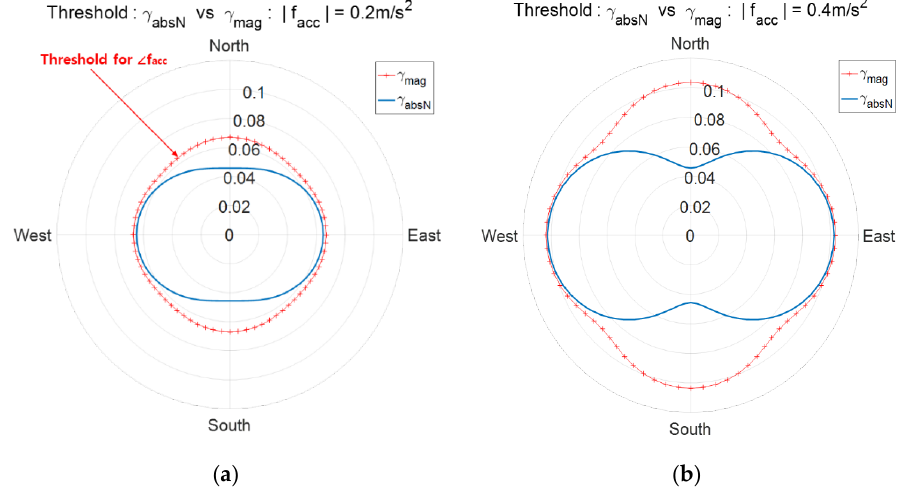
Figure 3. Spoofing detection thresholds γ mag and γ absN according to the moving acceleration. The distance from the origin is the threshold for the corresponding direction of moving acceleration; ( a ) |𝑓 𝑎𝑐𝑐 | = 0.2𝑚/𝑠 2 , ( b ) |𝑓 𝑎𝑐𝑐 | = 0.4𝑚/𝑠 2 .